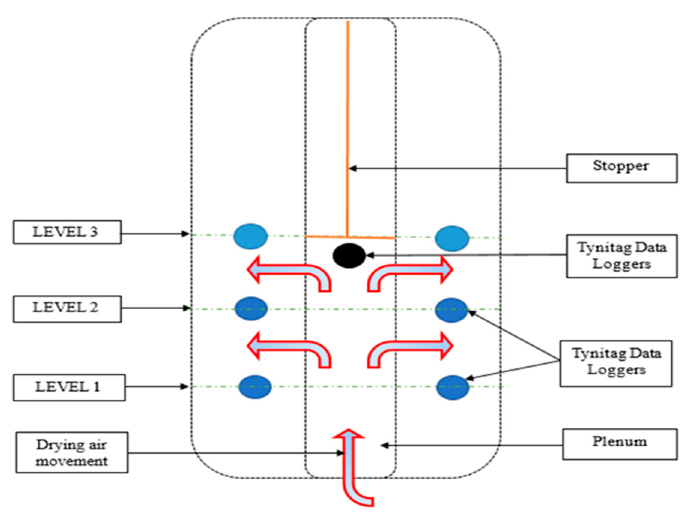
Figure 2. Longitudinal cross-section showing points of data collection.